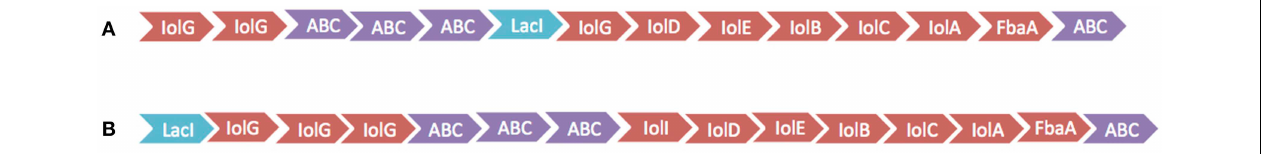
FIGURE 3 | Diagram of inositol utilization clusters. (A) Cluster found in 1MC16, G. thermodenitrificans DSM 465 and G. thermodenitrificans NG80-2. (B) Cluster found in G. kaustophilus HTA426, Geobacillus subterraneus PSS2, G. thermoglucosidasius M10EXG, and G. thermocatenulatus GS-1.